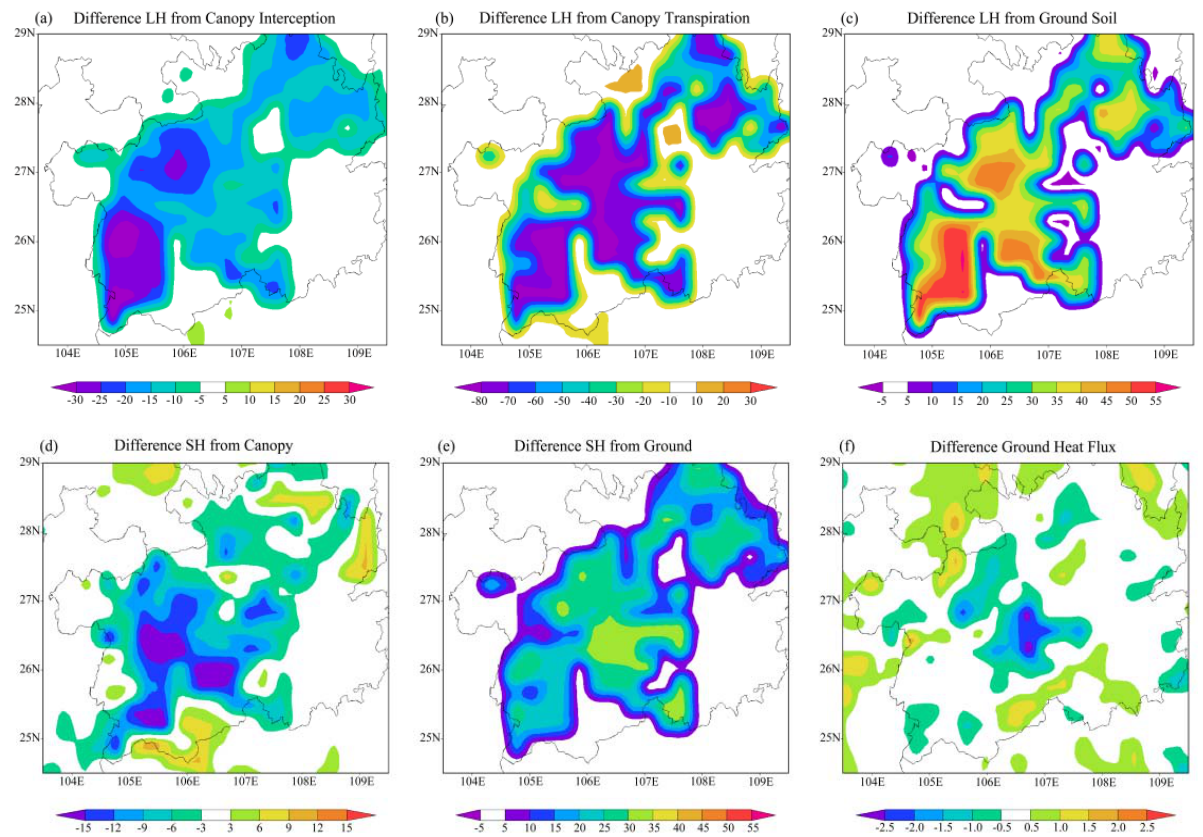
Figure 4. Ensemble mean differences in JJA ( a ) latent heat flux from interception; ( b ) latent heat flux from canopy transpiration; ( c ) latent heat flux from ground soil; ( d ) sensible heat flux from canopy; ( e ) sensible heat flux from ground and ( f ) ground heat flux (W/m 2 ) between Case D and Case C.